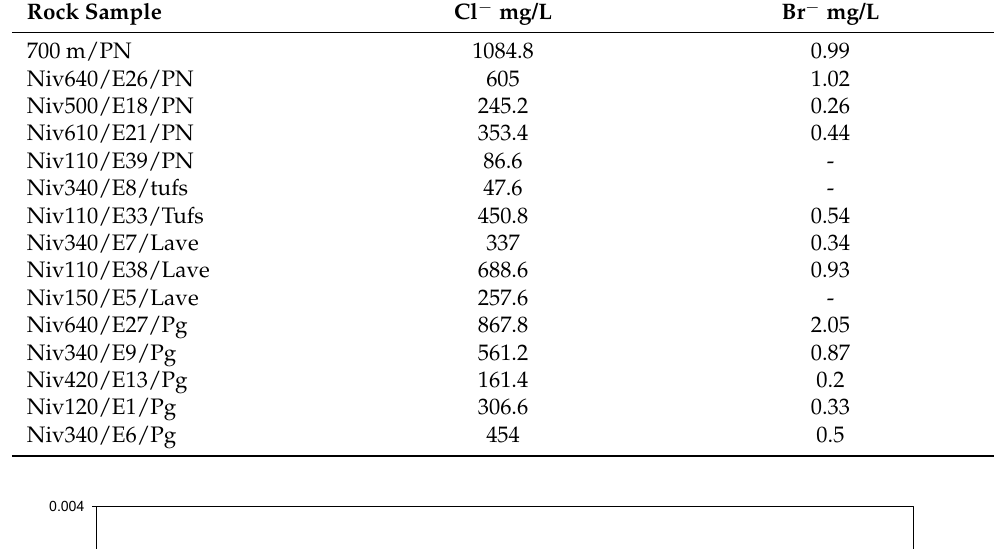
Table 3. Cl ‐ and Br ‐ concentrations in rock leachate.